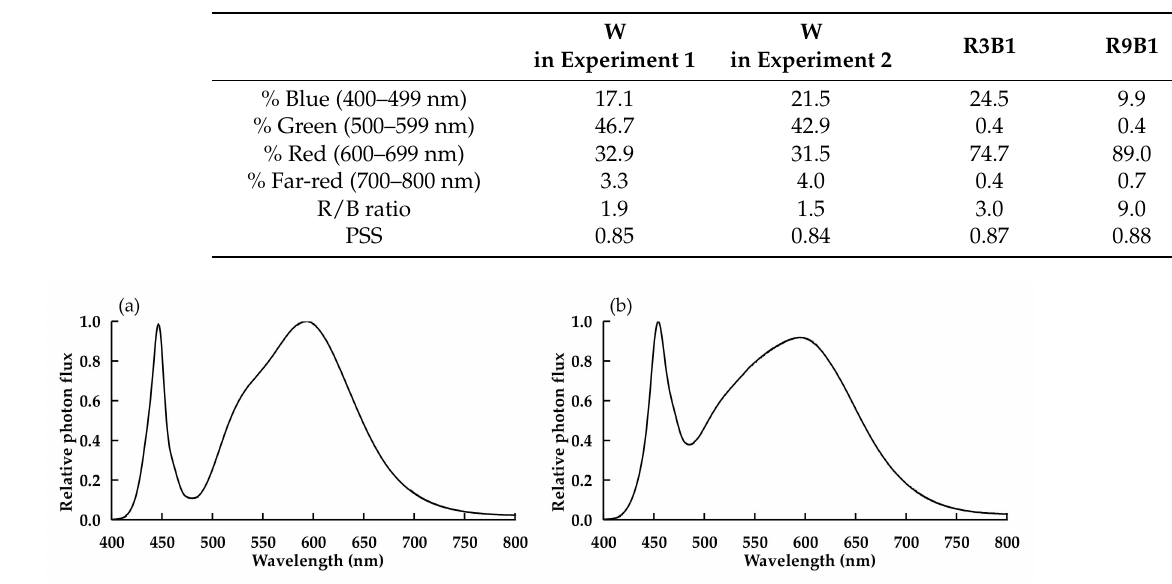
Table 11. Spectral data for LED lamps at the wavelength of 400–700 nm. ‘%’ represents the ratios of blue, green, red, and far-red photon fluxes as a percentage of photon flux density. R/B ratio represents the photon flux ratio of red light to blue light. ‘W’ represents white LED lamps. R3B1 and R9B1 represent red-blue LED lamps with photon flux ratios of 3:1 and 9:1, respectively, of red to blue light. The phytochrome photostationary state (PSS) is calculated using spectral composition and intensity of light received by plants [71,72].